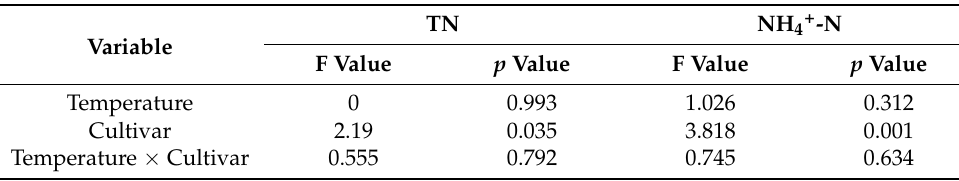
Table 3. Two-way ANOVA on TN and NH 4+ -N